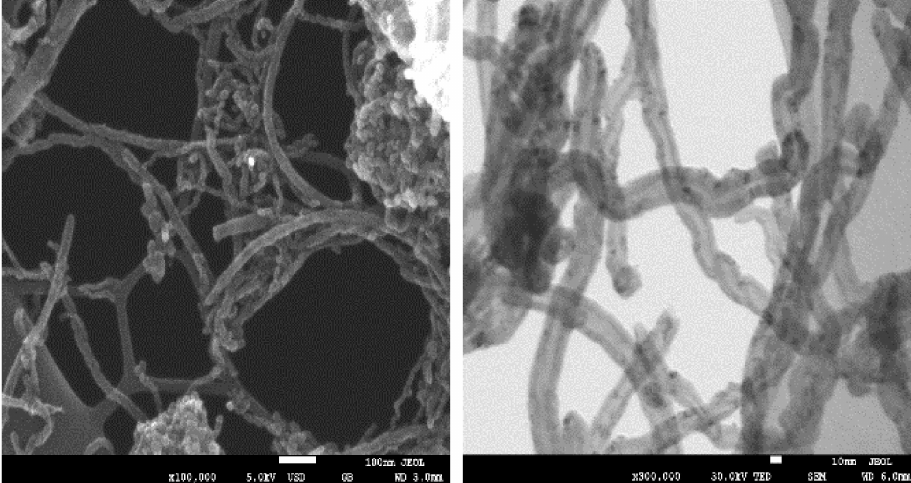
Figure 1. ( a ) scanning electron microscope (SEM, 100 × magnification) and ( b ) transmission